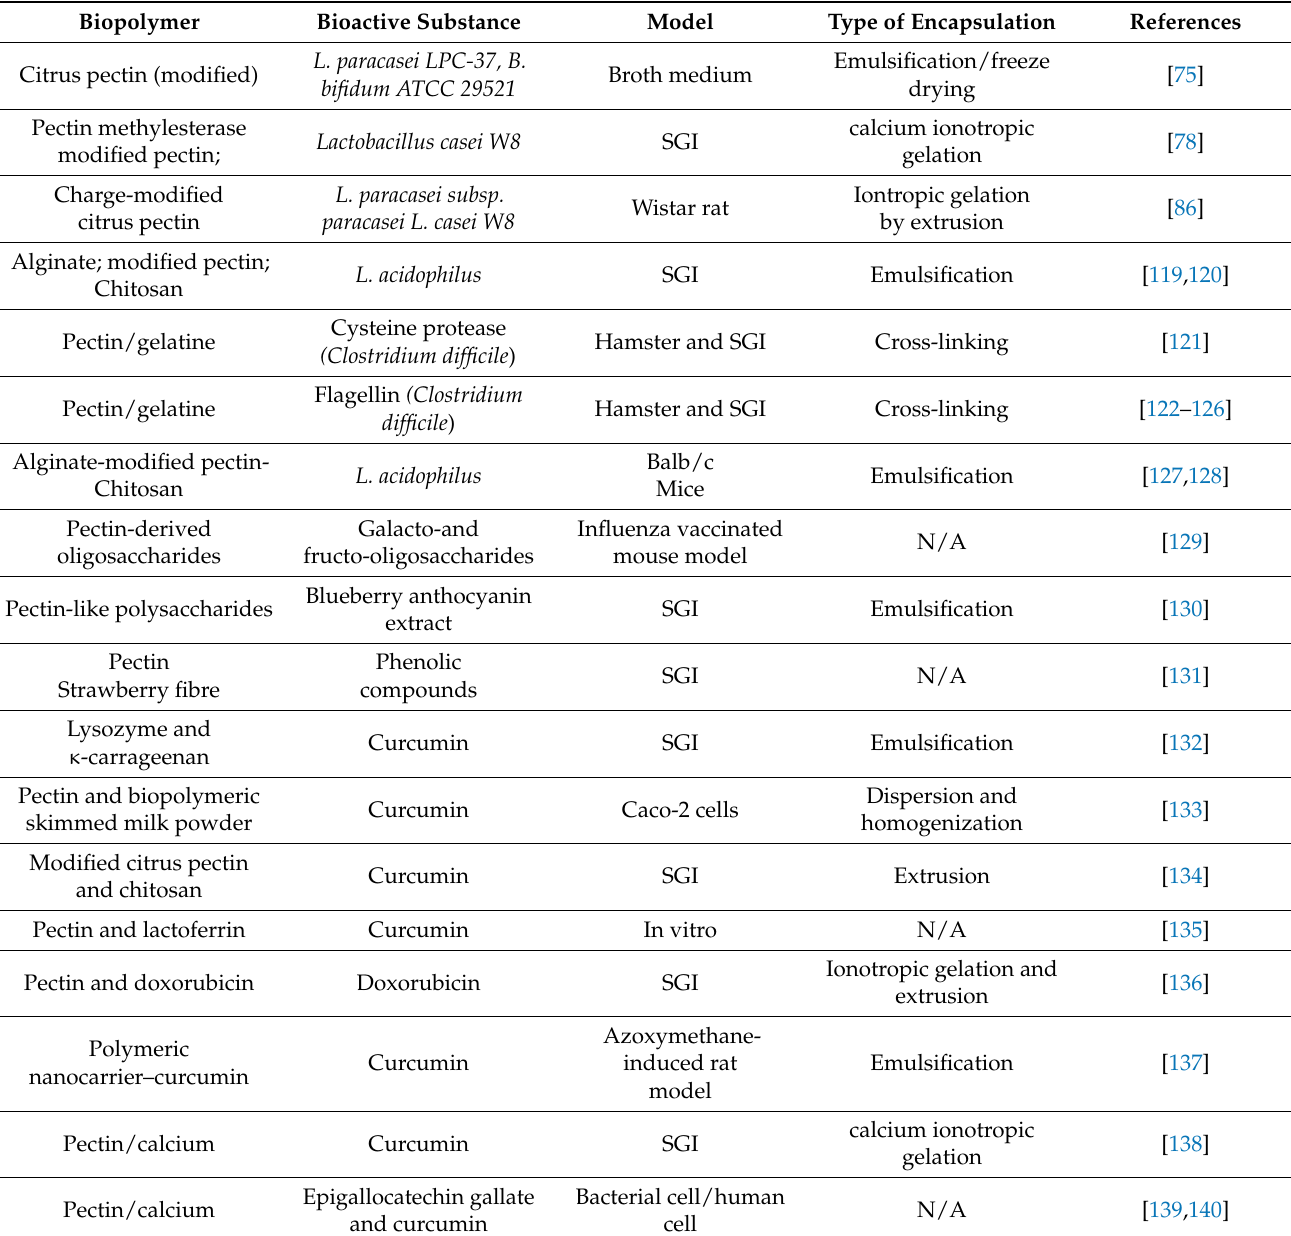
Table 3. Applications of (modified) pectin as a biopolymer